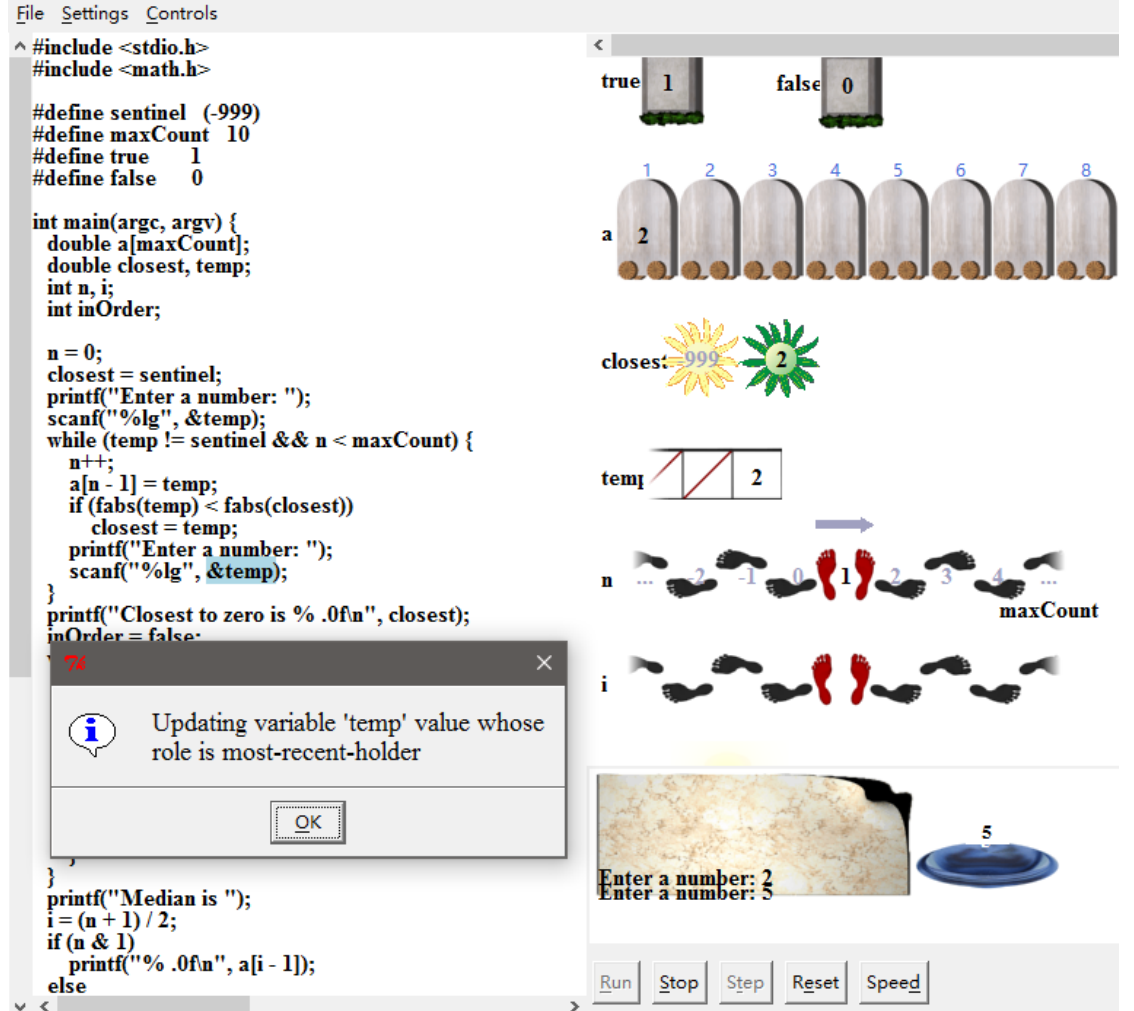
Table 1. SOLO categories for program comprehension [35] .